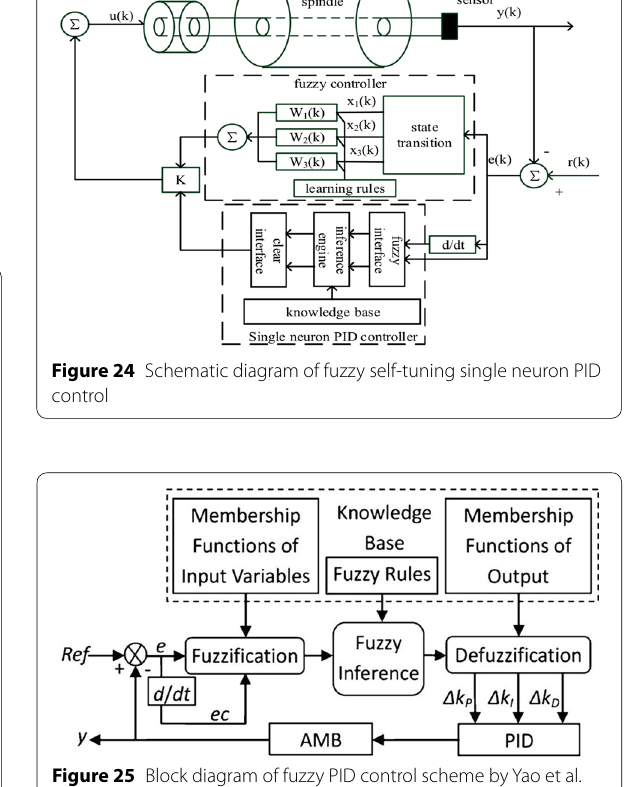
Figure 25 Block diagram of fuzzy PID control scheme by Yao et al.